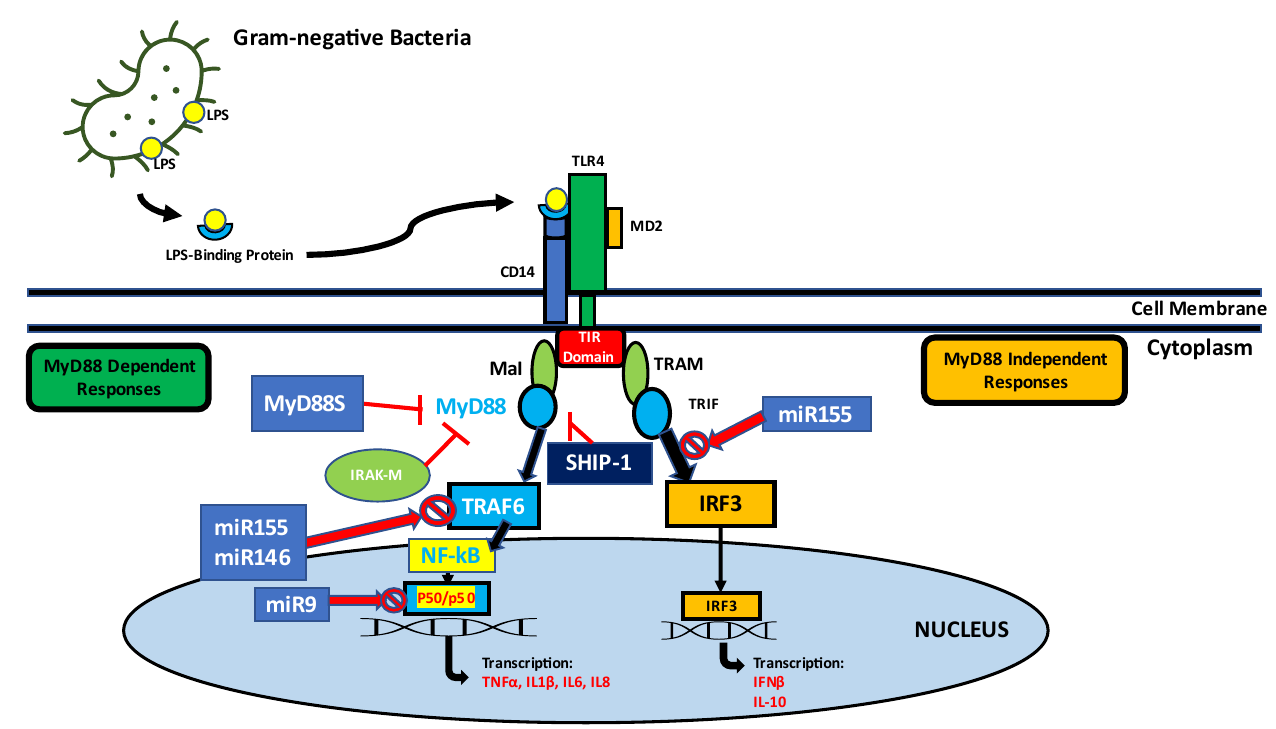
Figure 1. Endotoxin tolerance (ET) is defined as the reduced ability of cells to respond after exposure to endotoxin. The body becomes tolerant to subsequent attacks by lethal doses of endotoxin, and cytokine release and cell/tissue damage due to inflammatory responses are greatly reduced in endotoxin-resistant conditions. Key features of endotoxin tolerance are down-regulation of inflam- matory mediators such as tumor necrosis factor (TNF- α ) and interleukin-1 β (IL-1 β ), upregulation of pro-inflammatory cytokines such as IL-10 and increased transforming growth factor (TGF- β ). Alternative variants of MyD88S lacking an intermediate domain (ID) show a predominantly negative effect of suppressing the immune response by suppressing the MyD88 pathway. Tolerance media- tors such as MyD88s, IRAK-M, and SHIP-1 are upregulated. In the endotoxin resistance phase, three LPS-inducible miRNAs (miR-155, miR- 146α, and miR -9), were shown to mediate gene colocaliza- tion and transcription factor binding by blocking the binding of NF-kB p50 dimers and IRF3 as well as TRAF6-dependent NF-kB pathway, which contributes to the regulation of tolerance to endotox- ins.